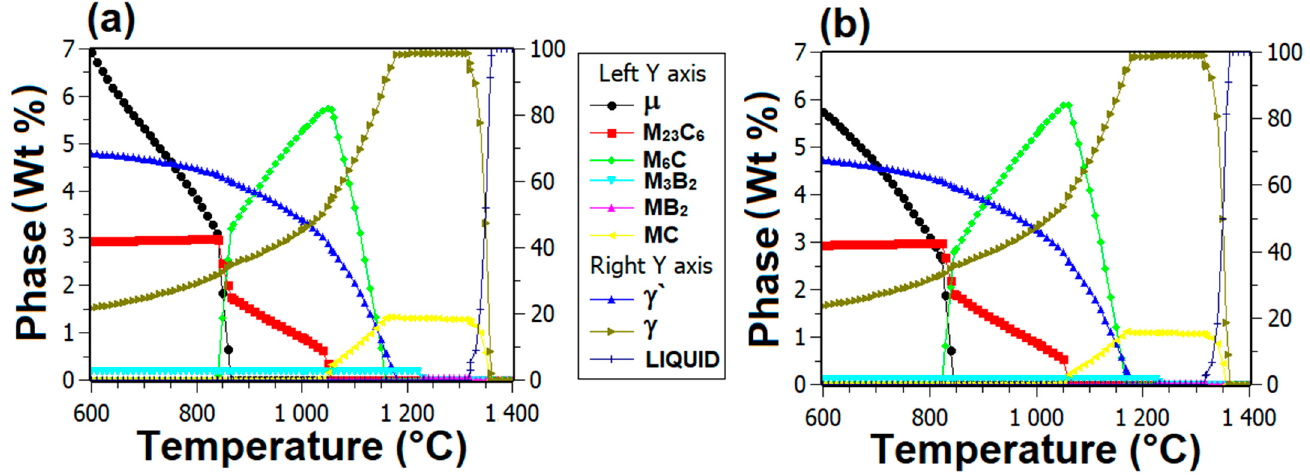
Figure 7. Thermodynamic simulations for phase variation. ( a ) MAR-M246(Ta), ( b ) MAR-M246(Nb).